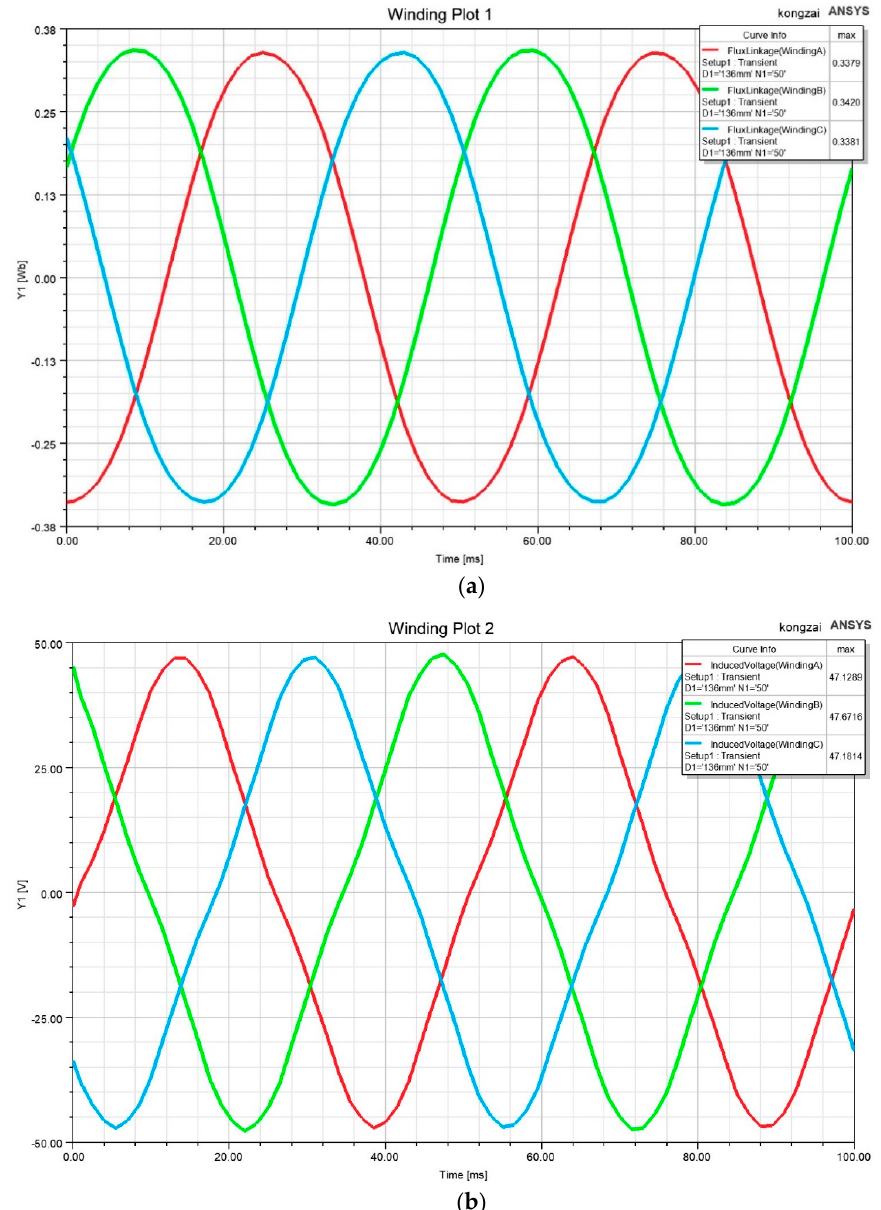
Figure 7. PMLSM flux and back − EMF waveform diagram ( a ) Motor flux waveform diagram ( b ) Motor back EMF waveform diagram.